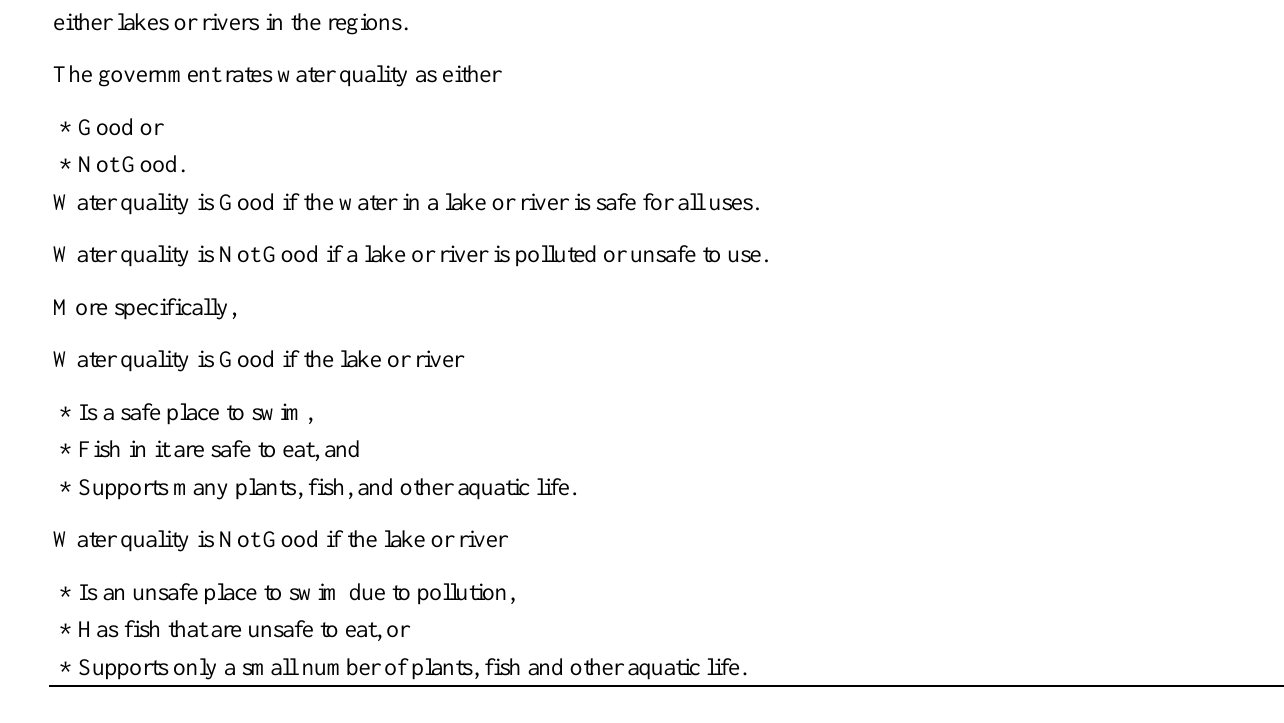
Figure 1. Text of water quality definition in